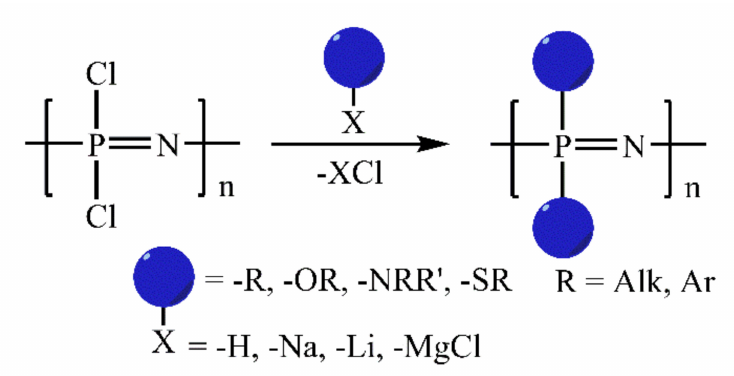
Figure 1. Nucleophilic substitution of chlorine atoms in